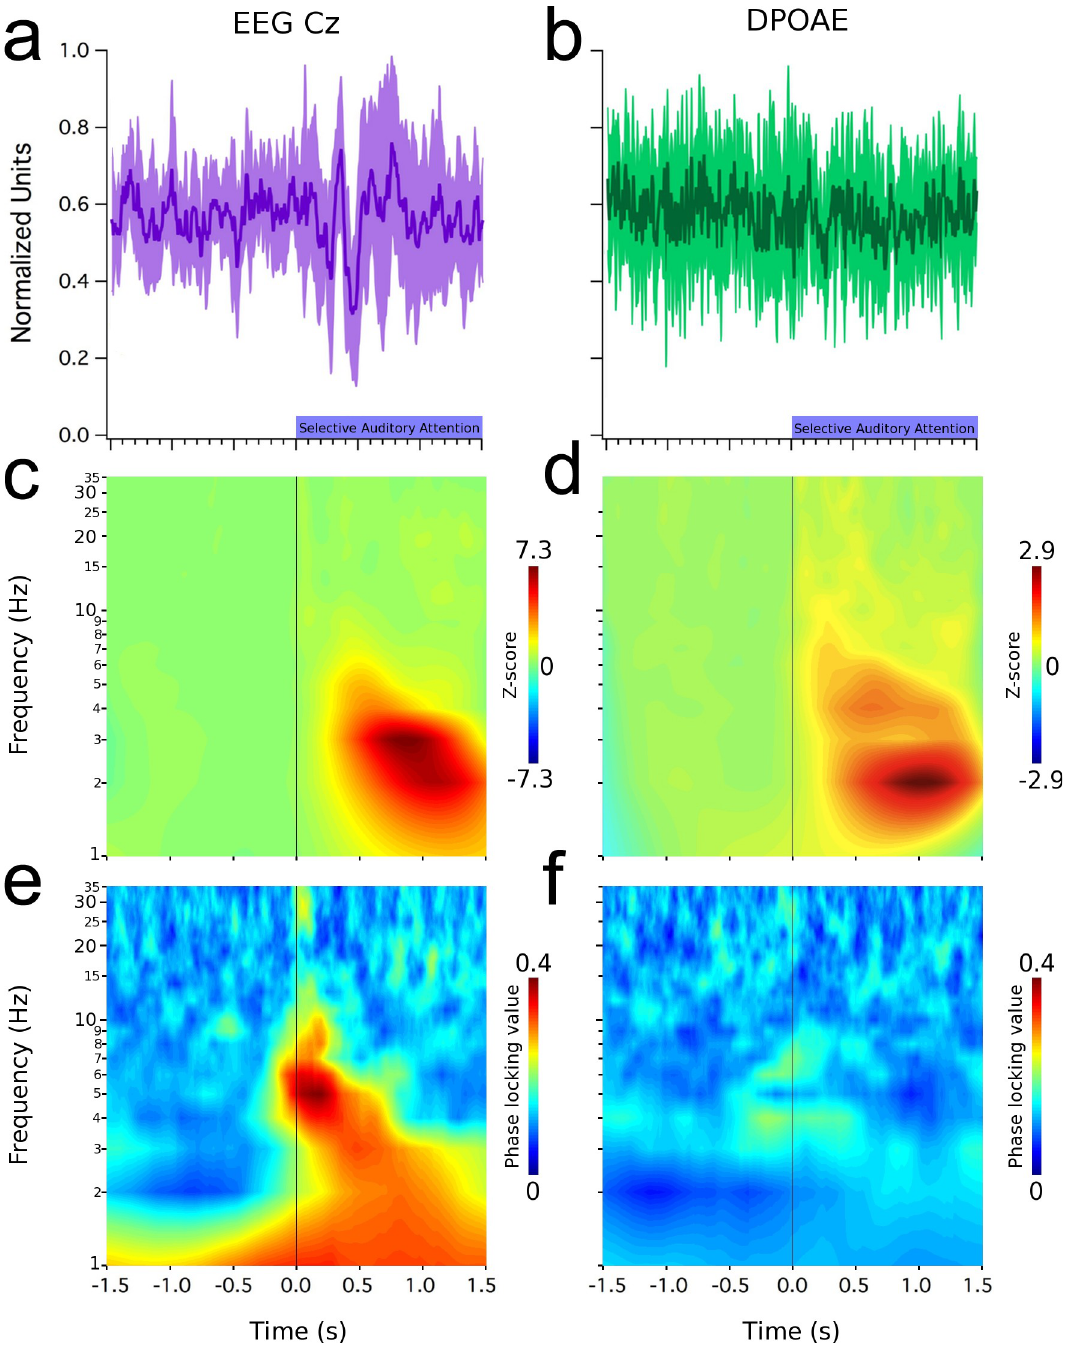
Fig 2. Low-frequency oscillations ( < 10 Hz) in EEG (Cz electrode) and in the cochlea (DPOAE) during selective auditory attention. Time and frequency graphs represent grand average data. Left column shows: (a) evoked oscillations at Cz electrode (mean latencies: positive peak: 297 ± 6 ms; negative peak: 420 ± 9 ms), (c) time spectrum and (e) an increased phase locking value of these brain oscillations. Right column shows: (b) a lack of evoked effects in the amplitude of DPOAEs, (d) low frequency induced DPOAE amplitude oscillations observed between 1 and 7 Hz. (f) Notice the presence of small regions of DPAOE phase locking around 0 ms in cochlear oscillations. Shaded purple and green areas in (a) and (b) represent data dispersion ( ± 1 standard deviation).